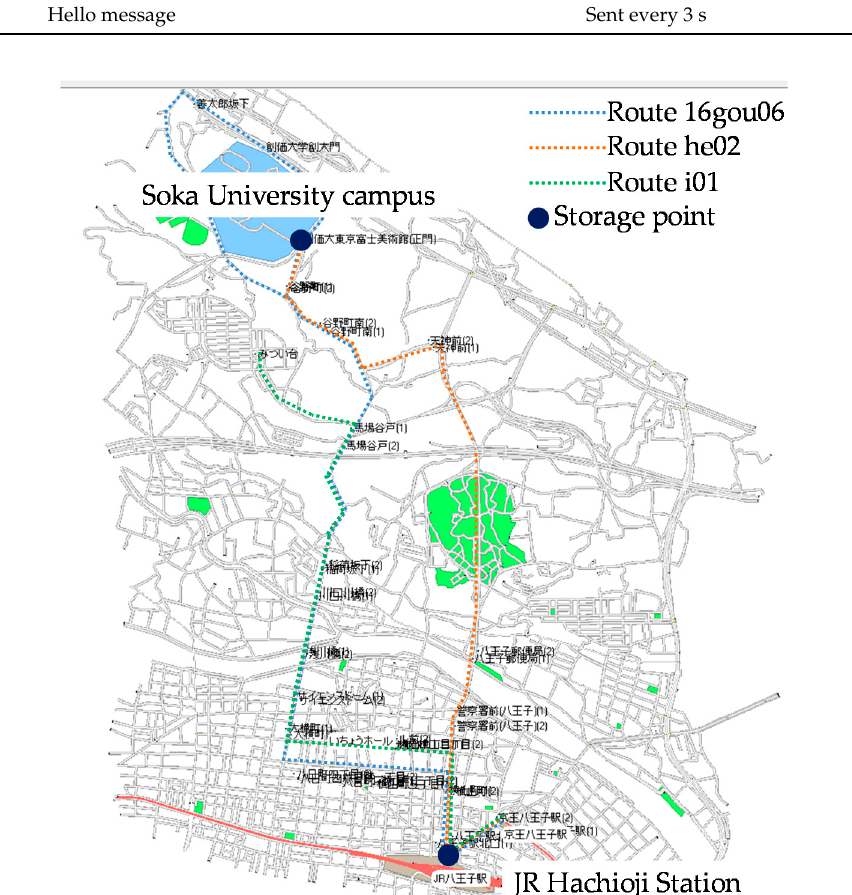
Figure 19. Locations of the sending nodes and destination areas. Note: JR; Japan Railway. 6.2. Implementation Conditions for Destination Areas in the Existing Routing Methods